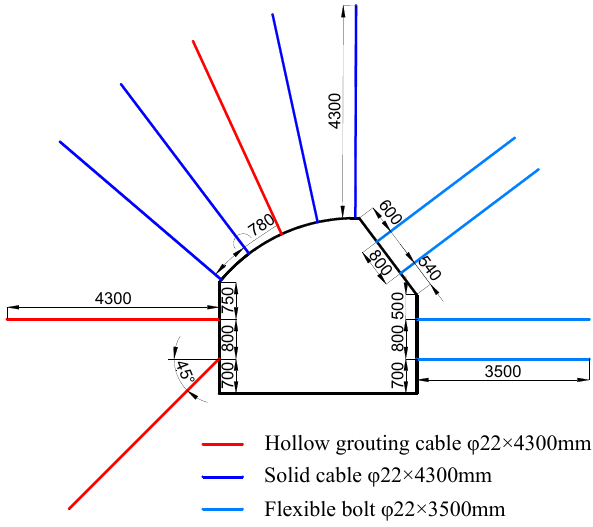
Figure 14. New support scheme.